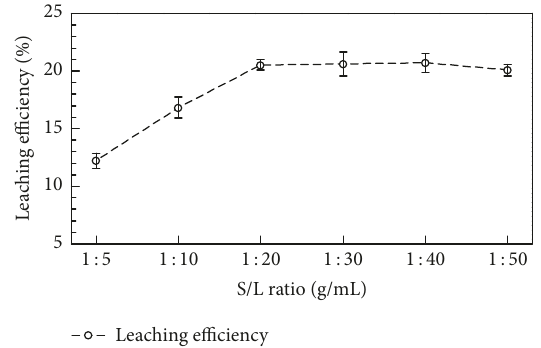
Figure 1: The leaching efficiency of uranium in 0.5 mol/L Na 2 CO 3 solution at various S/L